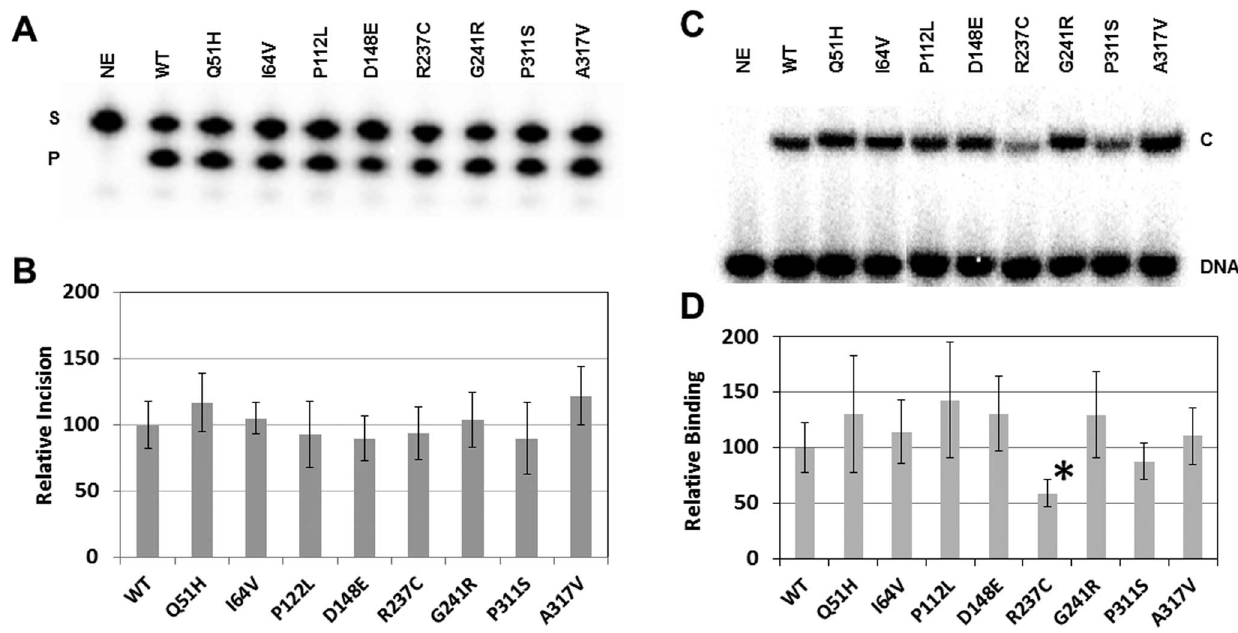
Figure 3. AP endonuclease incision and AP-DNA binding. ( A ) Wild-type (WT) and variant APE1 proteins (30 pg) were incubated with 32 P- labeled 18F NMR DNA substrate (0.5 pmol), and the reactions were resolved on a urea-polyacrylamide denaturing gel. The non-incised substrate (S) and incision product (P) bands were visualized and quantified using standard phosphorimaging analysis. NE=no enzyme. ( B ) Relative AP site incision efficiency. Shown are the average and standard deviations of at least 6 independent reactions. ( C ) Wild-type (WT) and variant APE1 proteins (2 ng) were incubated with 32 P-labeled 18F NMR DNA (100 fmol), and the binding reactions were resolved on a non-denaturing polyacrylamide gel. Standard phosphorimager analysis was employed to visualize unbound substrate (DNA) and the APE1-substrate complex (C). NE=no enzyme. ( D ) Relative AP-DNA binding affinity. Shown are the average and standard deviations of relative complex formation for at least 4 independent assays. *,